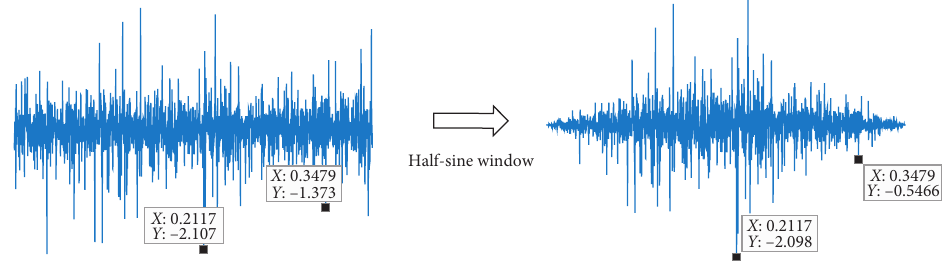
Figure 11: Windowing operation on the reference signals.